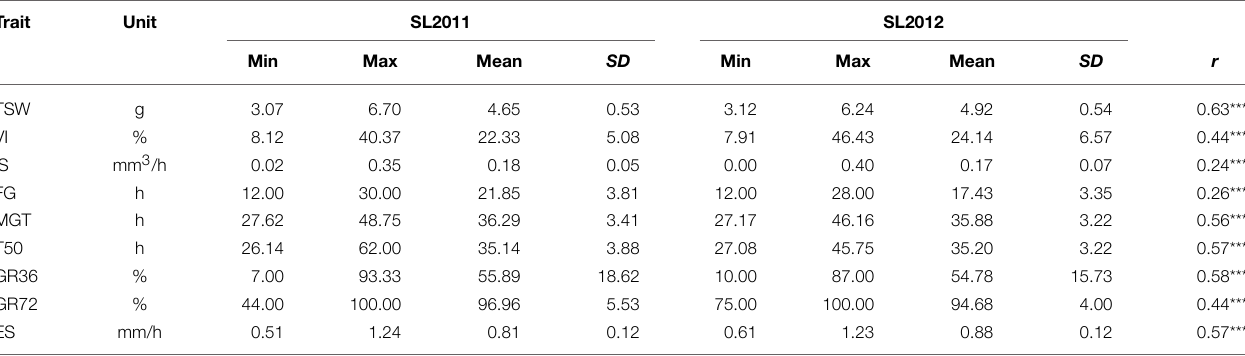
TABLE 1 | Phenotypic variation for different traits associated with seed germination performance in two seeds lots of a Brassica napus diversity panel (n = 248) produced in Le Rheu, France in 2011 (SL2011) and Asendorf, Germany in 2012 (SL2012), respectively: Minimum (Min), maximum (Max), standard deviation (SD) and correlation between seed lots (r).